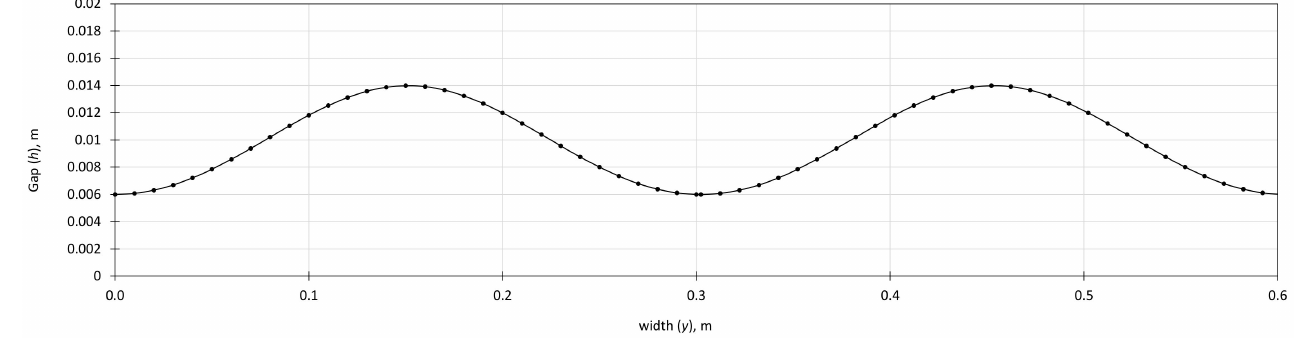
Figure 1. Variation of the gap over the width in the eccentric Hele–Shaw cell. This gap variation is machined on a 50 mm thick acrylic plate, which stands against a flat acrylic plate using a stainless-steel spacer, as shown in Figure 2. Six inlet and six outlet ports, and six 1/4-inch ports at a distance of 10 cm above the bottom of the cell and for releasing particles into the cell were designed.